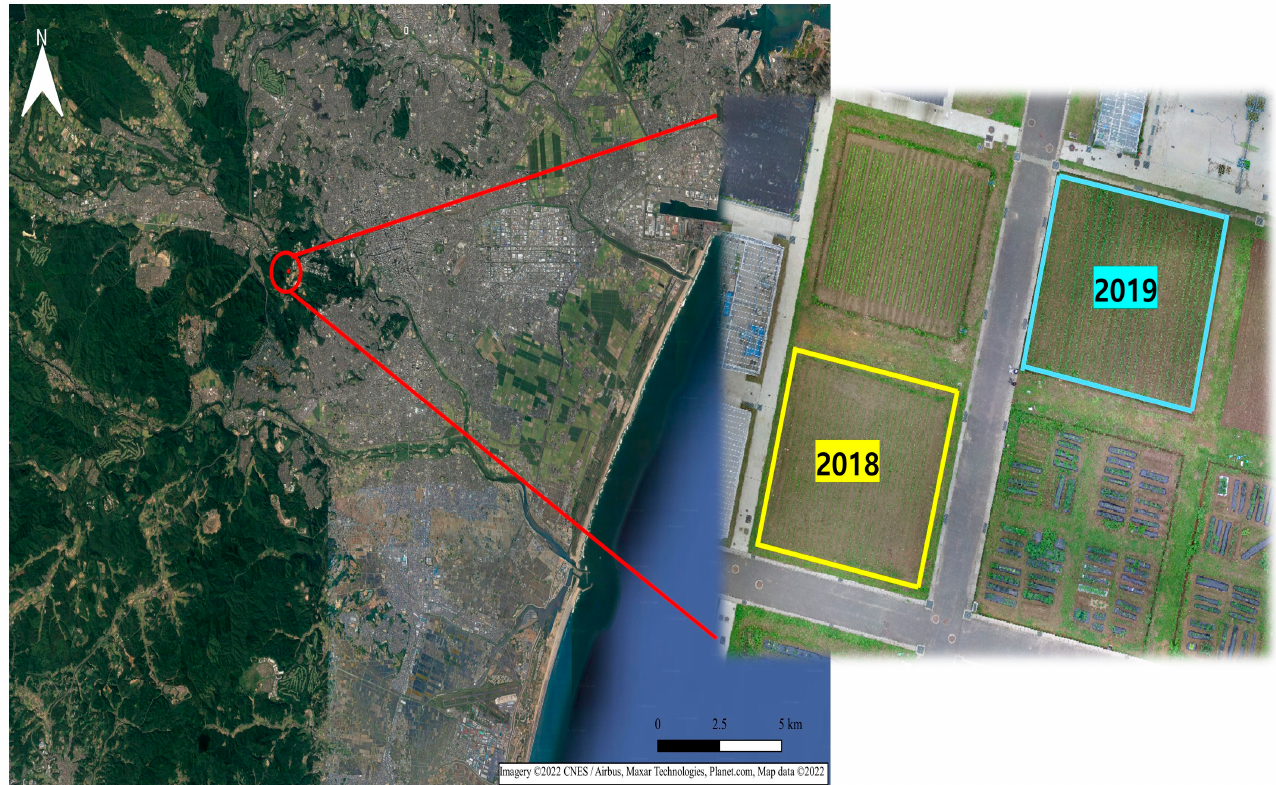
Figure 1. Experimental site. Biggest imagery on left-side image was captured from Google Maps. The detailed image on the right side is an RGB image taken by an unmanned aerial vehicle (UAV). Both two-year experiments were carried out at Tohoku University, but the experiments were conducted on different fields to prevent damage by continuous cropping. The area sizes of the fields were 0.03 and 0.04 ha for 2018 and 2019,